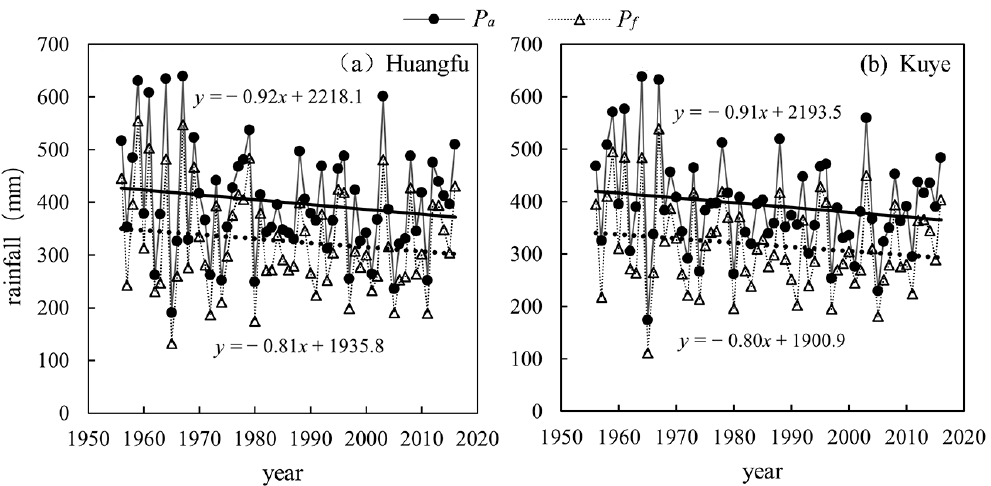
Figure 1. Variations of annual precipitation ( P a ) and flood season precipitation ( P f ) in the Huangfu basin ( a ) and the Kuye basin ( b ).